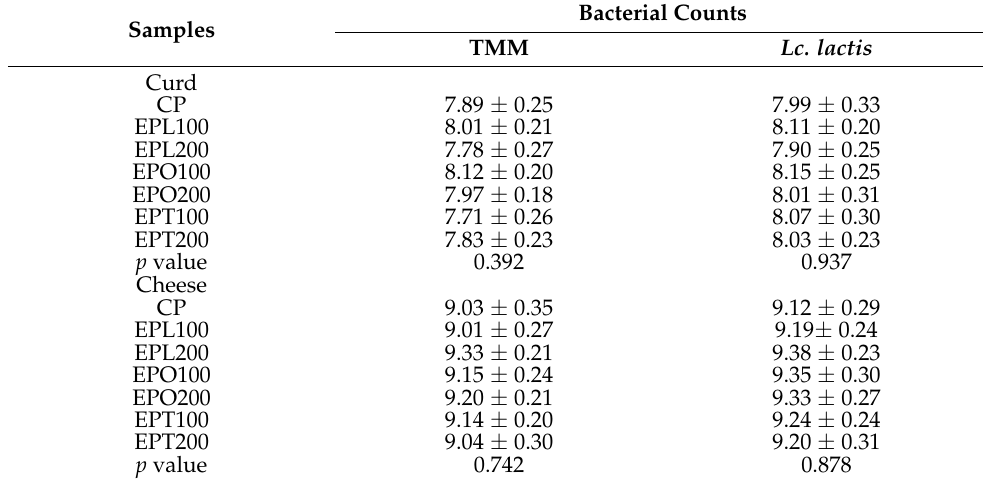
Table 2. Growth of starter LAB during cheese